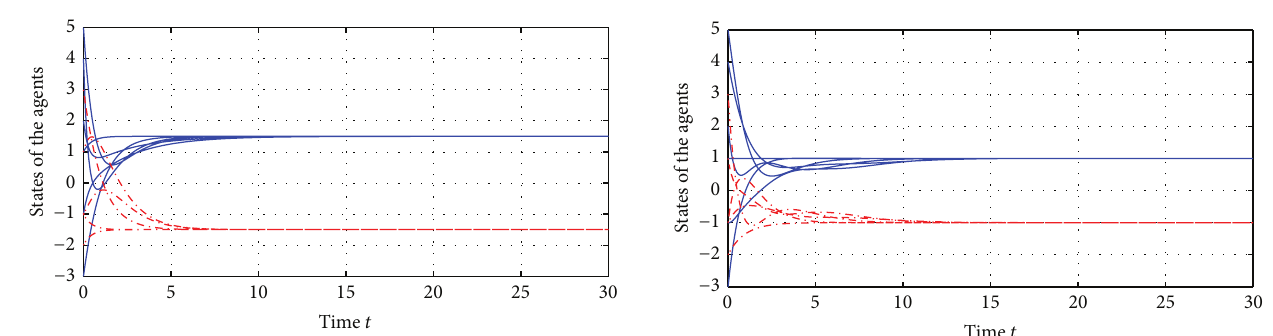
Figure 4: State evolution of agents on the bipartite coopetition network G 𝑠 .